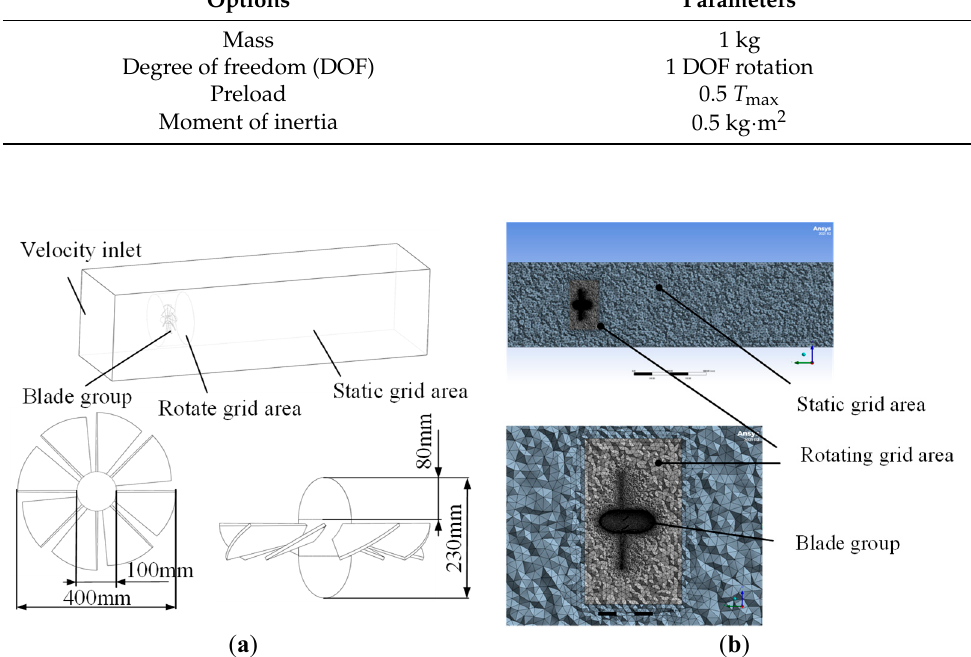
Figure 6. ( a ) Flow field model and simplified blade group model; ( b ) grid size comparison. Table 1. Six DOF parameters settings.